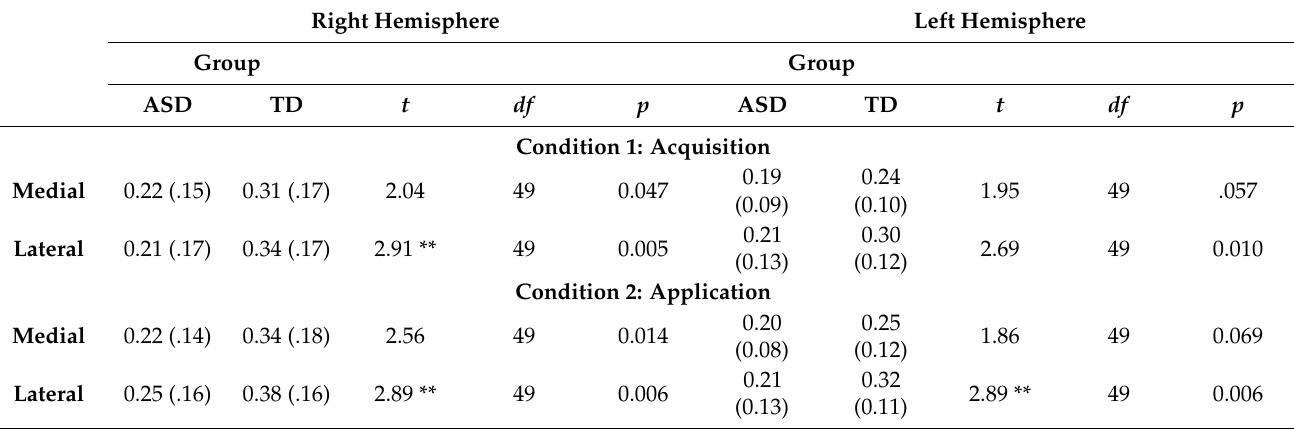
Table 4. fNIRS prefrontal functional connectivity during WCST in ASD and TD individuals ( r ).